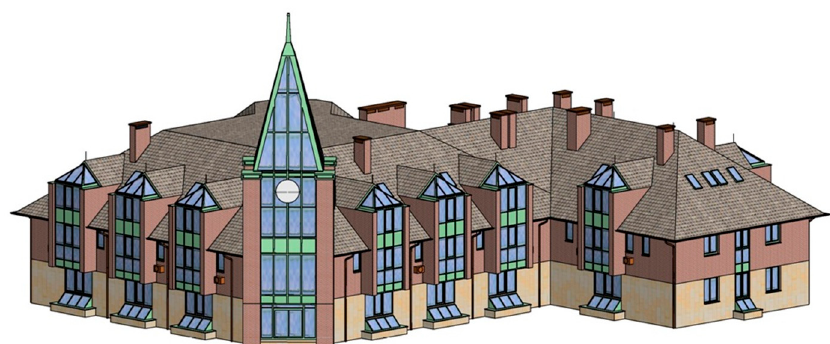
Figure 1. 3D model of the city hall, located within the studied area, modelled based on the data from terrestrial laser scanning. Source: own work.